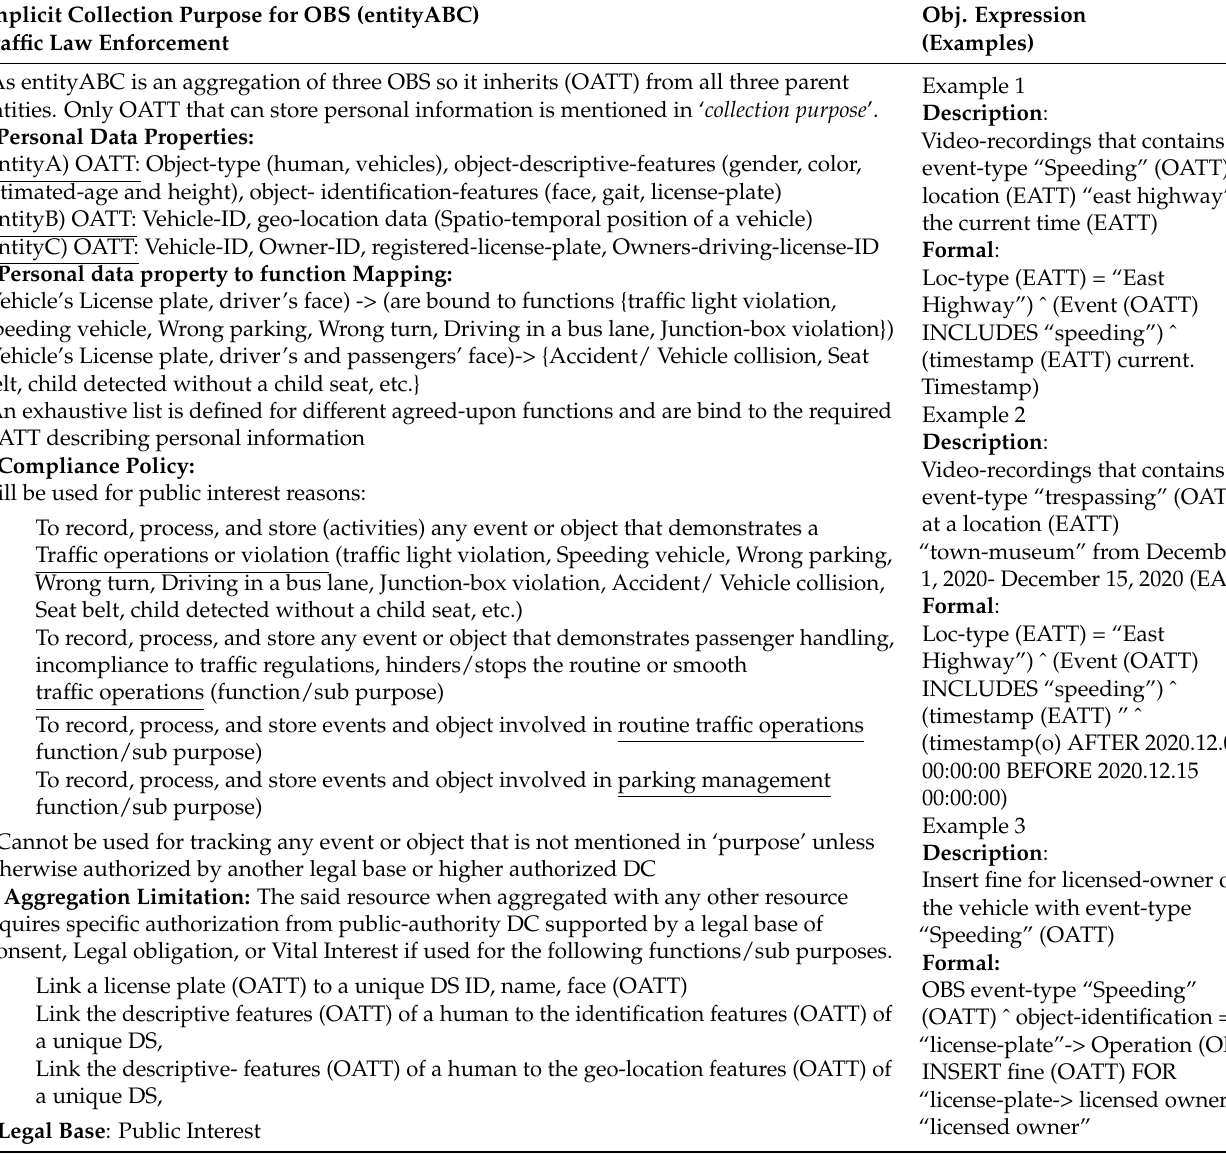
Table 4. An implicit collection purpose for OBS